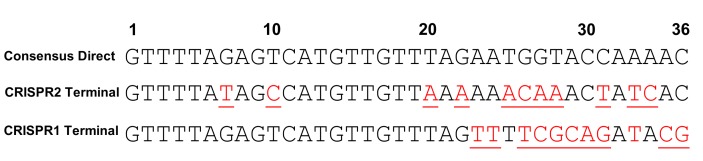
Repeat alignments.Alignments of the consensus direct repeat, the CRISPR2 terminal repeat, and the CRISPR1 terminal repeat are shown. Bases underlined indicate those that differ from the consensus CRISPR2 direct repeat.